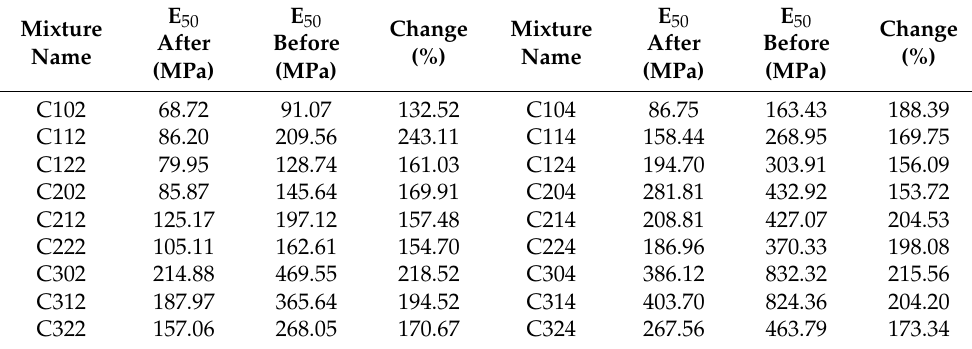
Table 8. Summary of unconfined compression strength